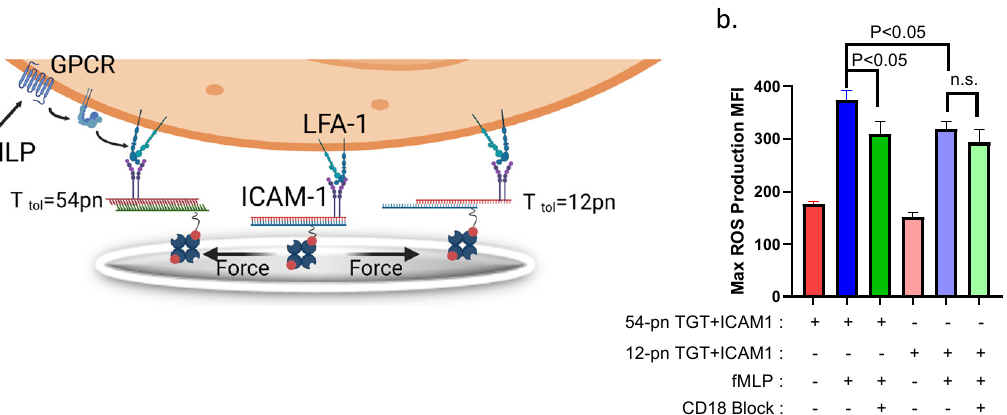
Figure 6. Bond tension acting on β 2 -integrins modulates superoxide production in neutrophils. ( a ) Schematic of neutrophils bound to 12pN or 54pN TGT presenting ICAM-1 in presence and absence of HA β 2 -integrin activated with fMLP. Shear force produced by oscillatory mixing greater than the TGT tolerance results in rupture. ( b ) Max ROS production for neutrophils bound to 54pN or 12pN TGT + ICAM-1 in the presence or absence of fMLP or CD18 blocking antibody IB4. All data are represented as mean +/- SEM, n = 3, bars indicate significance between mean values. Note that 12pN TGT + ICAM-1 did not register a significant increase compared to fMLP stimulation in absence of IB4).